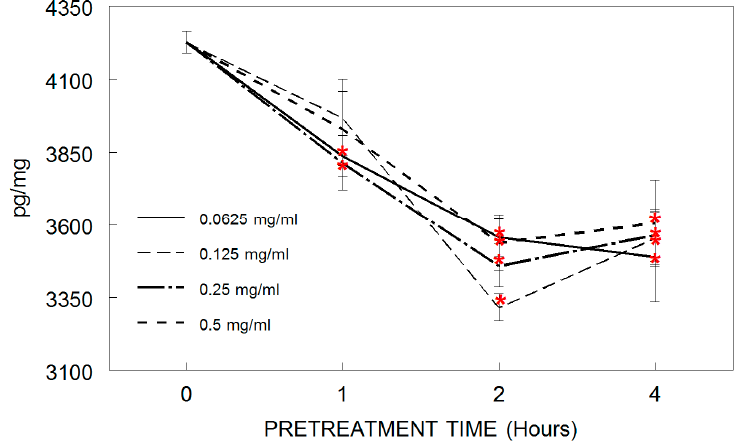
Figure 3. Suppression of tumor necrosis factor-alpha (TNF- α ) release in HAPI microglial cells pretreated with tart cherry powder (0.062, 0.125, 0.250, or 0.500 mg/mL) for 0 (LPS only/alone control), 1, 2, or 4 h and stimulated overnight with lipopolysaccharide (LPS, 100 ng/mL). Data are expressed as mean ± SEM (pg/mg of media) as assayed by enzyme-linked immunosorbent assay (ELISA). Each tart cherry pretreatment was compared against LPS treatment alone. Comparative post hoc analyses were made by Tukey’s HSD with significance at (*) p < 0.05 versus LPS.